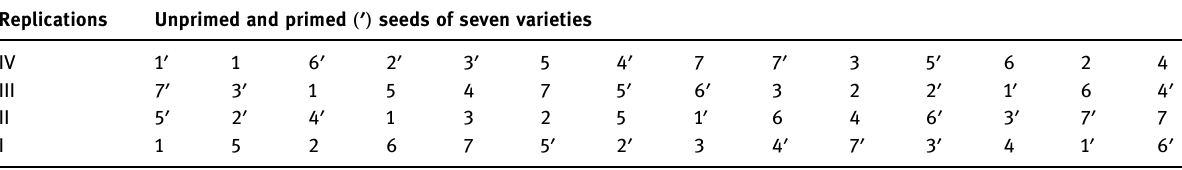
Table 1: Experimental design